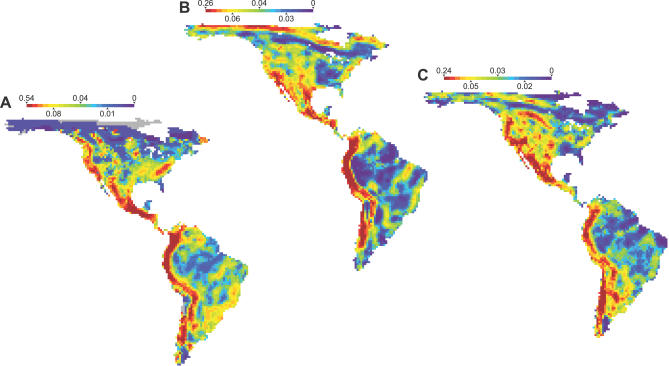
Beta-Diversity of Amphibians, Birds, and Mammals Mapped Continuously across the Continental Western HemisphereBeta-diversity (βsim-d) values for each taxon are divided into 20 quantiles, represented by warm (higher βsim-d) to cool (lower βsim-d) colors. The scale accompanying the color ramp for each taxon shows minimum, first quartile, median, third quartile, and maximum values of βsim-d. Gray grid cells do not contain amphibian species. (A) Amphibians. (B) Birds. (C) Mammals.